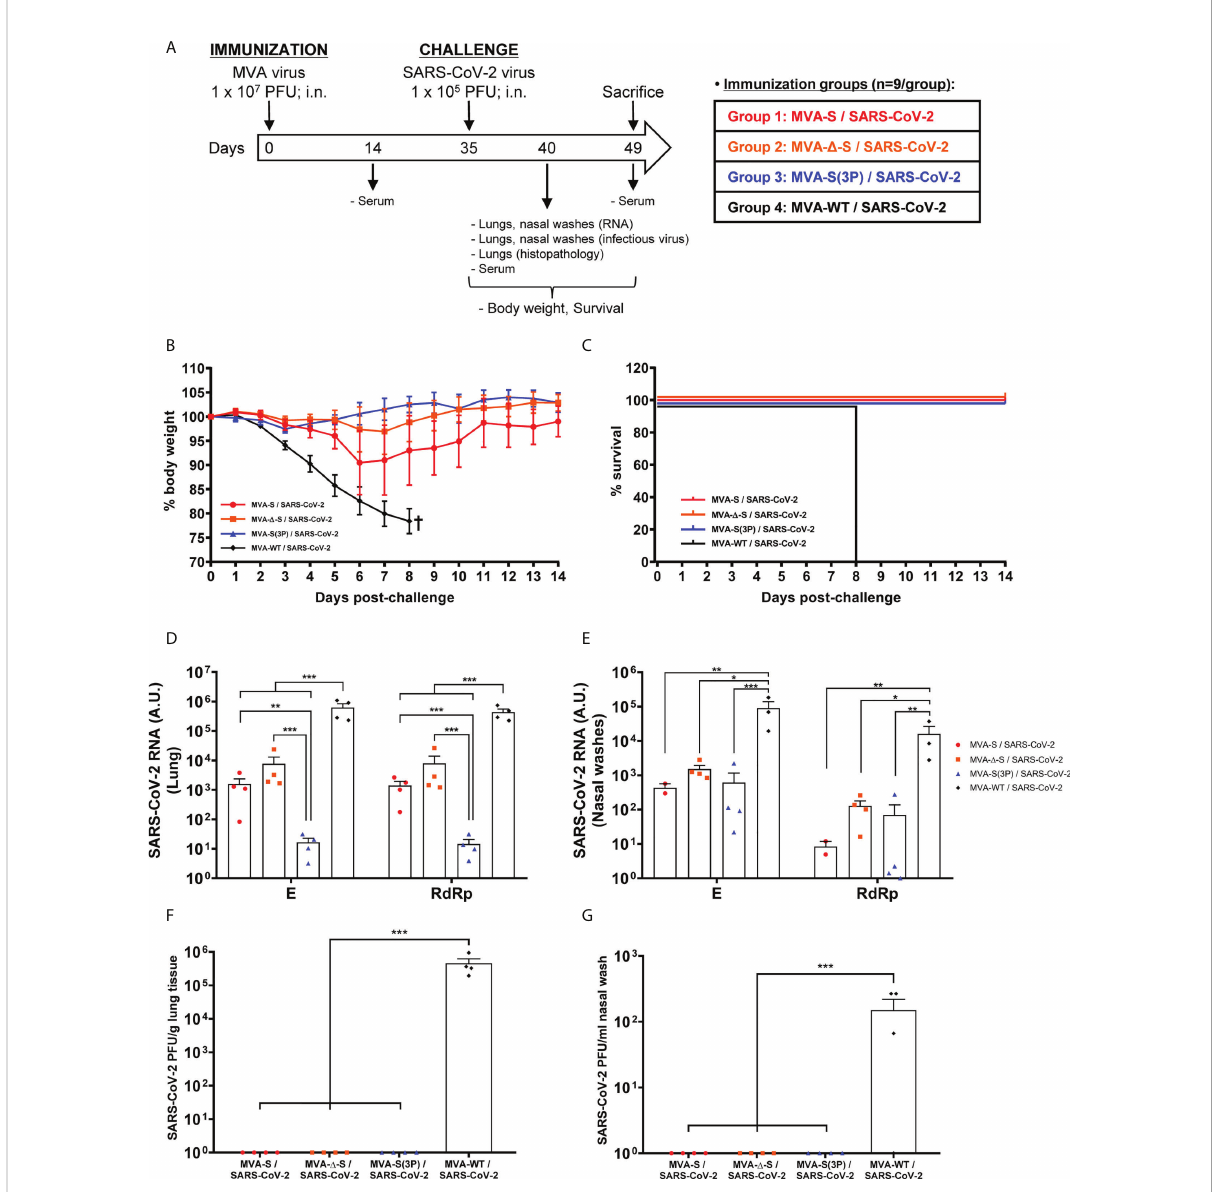
FIGURE 3 One IN dose of MVA-based vaccine candidates protects transgenic K18-hACE2 mice from SARS-CoV-2 infection. (A) Ef fi cacy schedule. Female K18-hACE2 transgenic mice ( n = 9 per group) were immunized by the IN route with one dose of 1 × 10 7 PFUs of MVA-S, MVA- D -S, or MVA-S (3P) as indicated. At week 5 (day 35), mice were challenged intranasally with 1 × 10 5 PFUs of SARS-CoV-2 (MAD6 isolate). MVA-WT-inoculated control mice were also challenged with SARS-CoV-2. At day 5 postchallenge, four mice per group were sacri fi ced and lungs, nasal washes, and serum samples were collected as indicated. Serum was also collected at 14 days after immunization in all groups and at 14 days postchallenge in groups 1, 2, and 3. (B, C) The challenged mice were monitored for change of body weight (B) and mortality (C) for 14 days. † : mice were euthanized due to loss of more than 20% of initial body weight. (D, E) Virus replication in lung samples (D) and nasal washes (E) . SARS-CoV-2 subgenomic E and genomic RdRp mRNA detected by RT-qPCR at 5 days after virus infection ( n =4/group). Mean RNA levels (in arbitrary units [A.U.]) and SEM from duplicates of each lung and nasal washes samples; relative values are referred to uninfected mice. (F, G) SARS-CoV-2 infectious virus in lung samples (F) and nasal washes (G) . Mean (PFUs/g of lung tissue or PFUs /ml of nasal wash) and SEM from triplicates of each sample. Student ’ s t -test: * p < 0.05; ** p < 0.005; *** p <